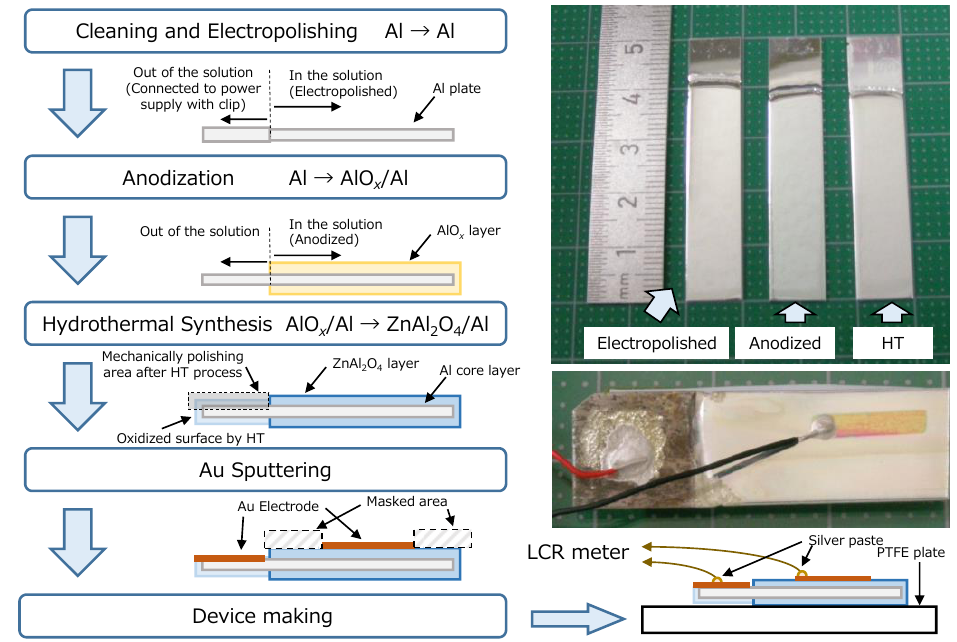
Figure 1. The flow of the sample preparation process with schematic illustrations of the cross-sec- tional image of the sample at each step and real pictures of them. The upper picture shows the scale ( left side ), electropolished Al plate (second from the left), anodized electropolished plate (AlO x /Al: second from the right) and hydrothermal synthesized sample (ZnAl 2 O 4 /Al: right side ). Bottom pic- ture shows the device after measurement.